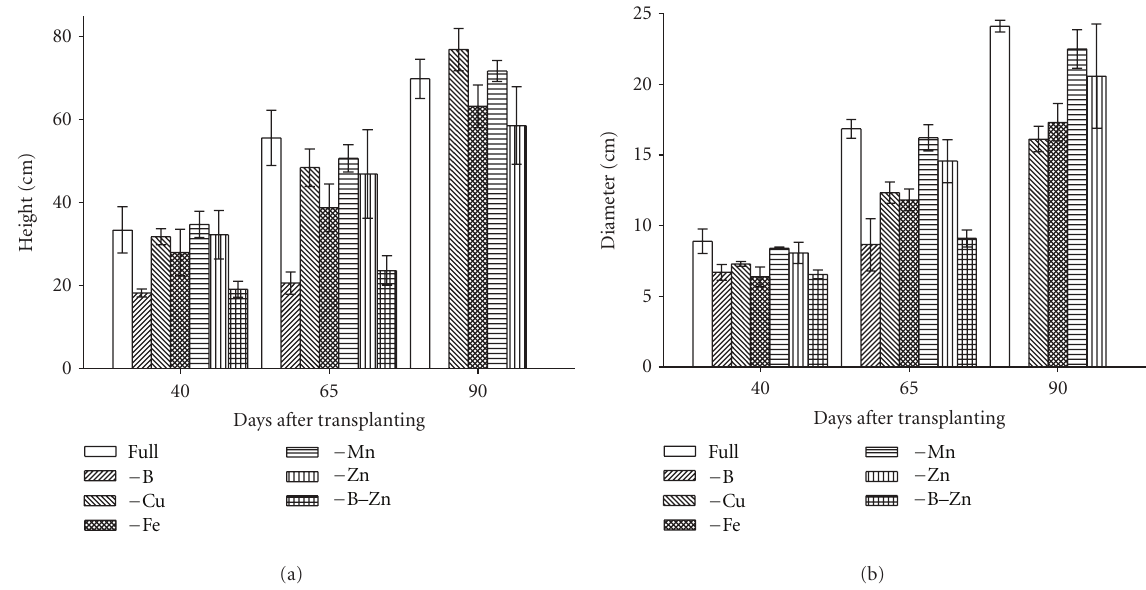
Figure 1: Height (a) and diameter (b) of the root collar of the Australian Red Cedar on the basis of the omission of Cu, Fe, Mn, B, and Zn, evaluated at 40, 65, and 90 days after transplanting.